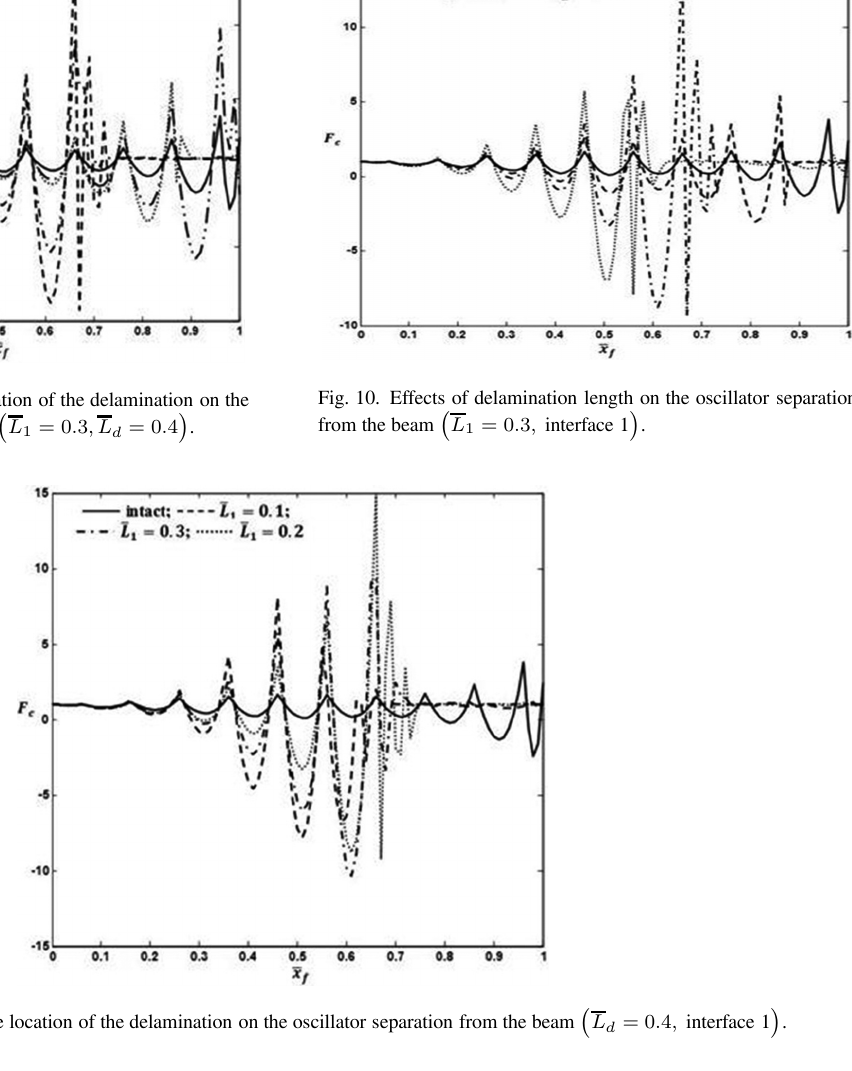
Fig. 11. Effects of spanwise location of the delamination on the oscillator separation from the beam